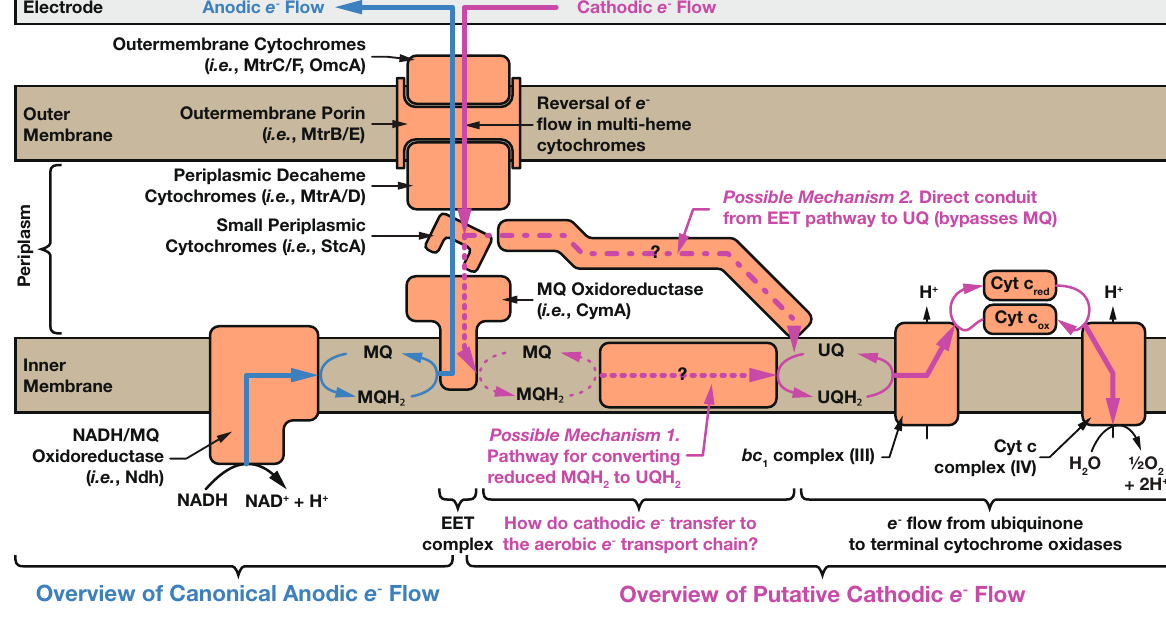
Fig. 1 Electron uptake in the model electroactive microbe Shewanella oneidensis MR-1 cannot be fully explained by reversal of its extracellular electron- transfer pathway. The canonical anodic extracellular electron-transport (EET) pathway for electron deposition is shown in light blue and the putative cathodic extracellular electron-uptake (EEU) pathway is shown in pink. Known electron-transfer pathways are denoted with solid lines, while speculated transfer pathways are shown as dashed lines. Two possible mechanisms for transfer of cathodic electrons from the Mtr EET complex to the ubiquinone pool and onto terminal cytochrome oxidases are highlighted. We speculate that two of the proteins identi fi ed in this work (SO_0400 and SO_3662) could form part of possible mechanism